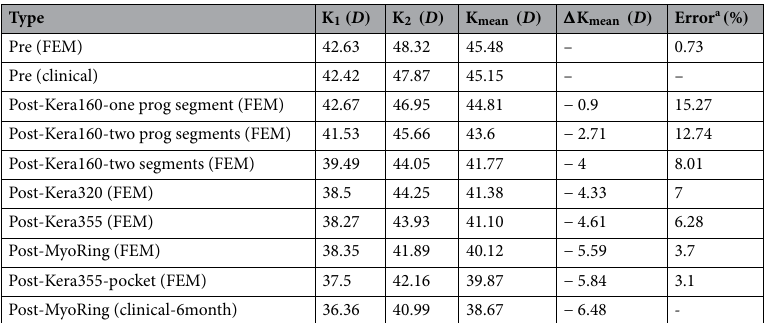
Table 2. Pre- and postoperative keratometry results of the second case. a Percentage error of FEM predictaed K mean .